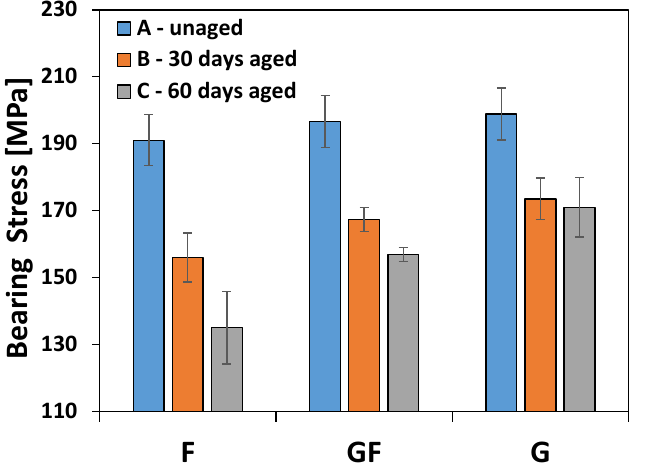
Figure 9. Bearing stress limits experimentally determined for all pinned laminates when varying the salt-fog exposition time.